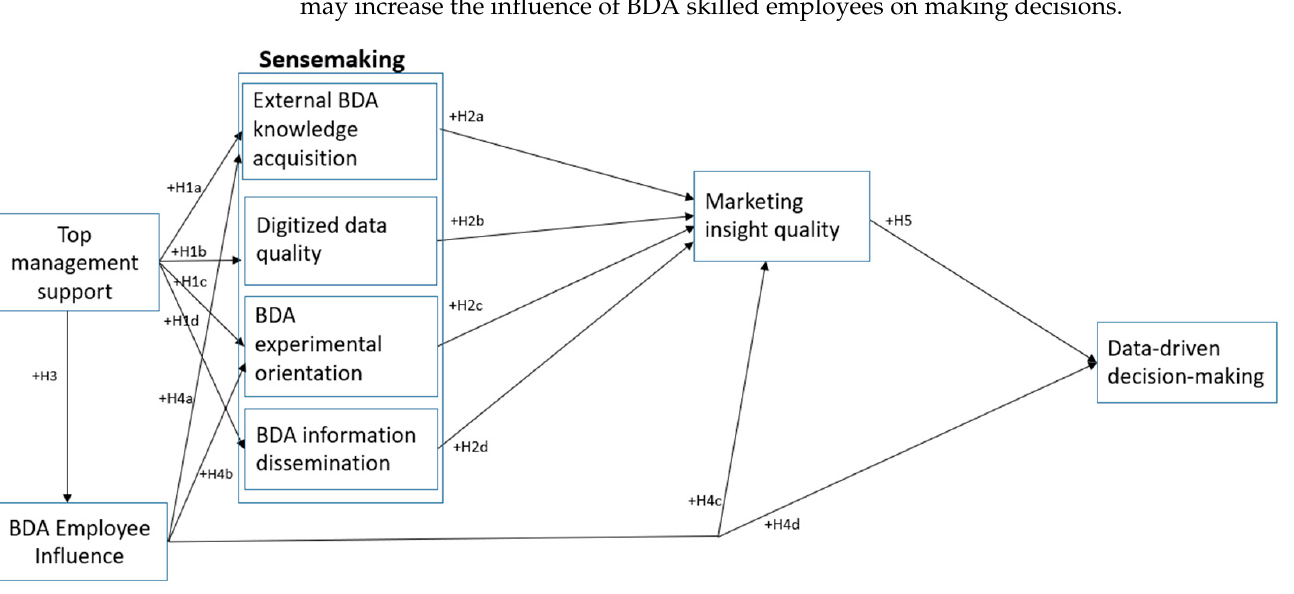
Figure 1. Marketing BDA Sensemaking and Data Driven Marketing.